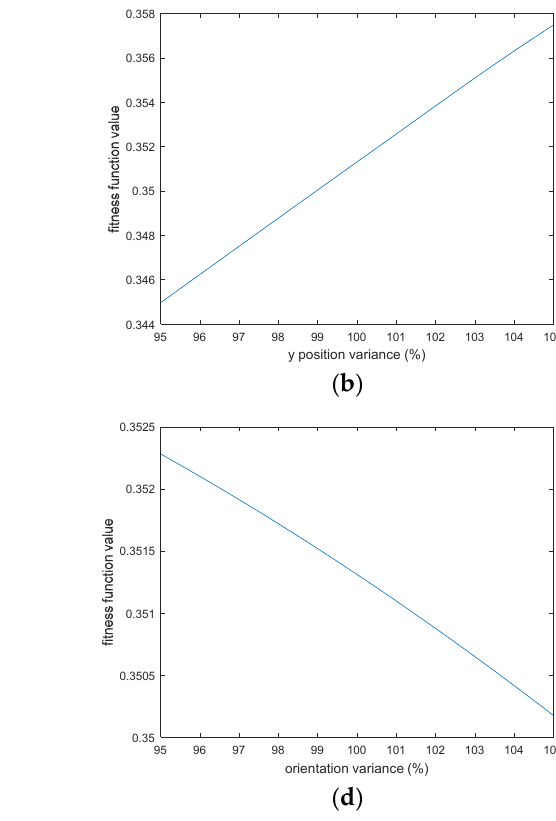
Figure 6. Sensitivity analysis for the results of the best placement of the path ‐ following task with respect to the considered variables: ( a ) x position, ( b ) y ‐ position, ( c ) z ‐ position, ( d ) orientation. The effect that the number of intermediate points placed between consecutive task points has on the optimization process was also examined, with respect to the path ‐ following task. Table 4 presents the optimization process duration and derived result with respect to the number of intermediate points inserted in each path segment. The task points set along the path and the population number were the same for all simulations. As seen, the increase in the number of points increases the required computational time, however the fitness function value is improved. Table 4. Effect of the number of intermediate points inserted along the path on the optimization process for the path ‐ following task.